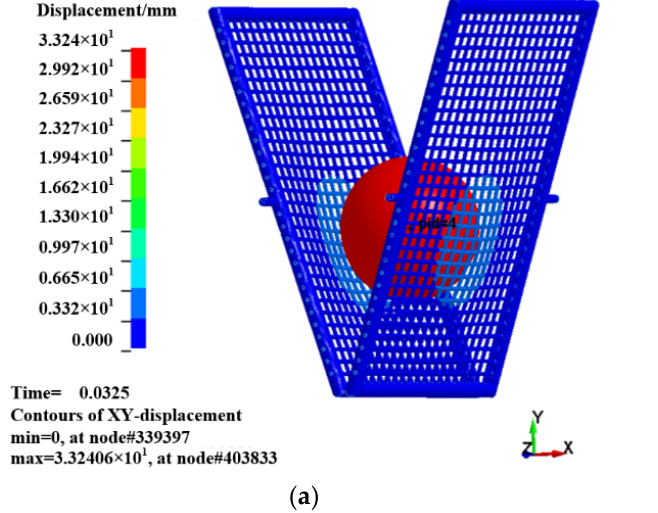
Figure 10. Simulation results of tomato drop in condition 2.